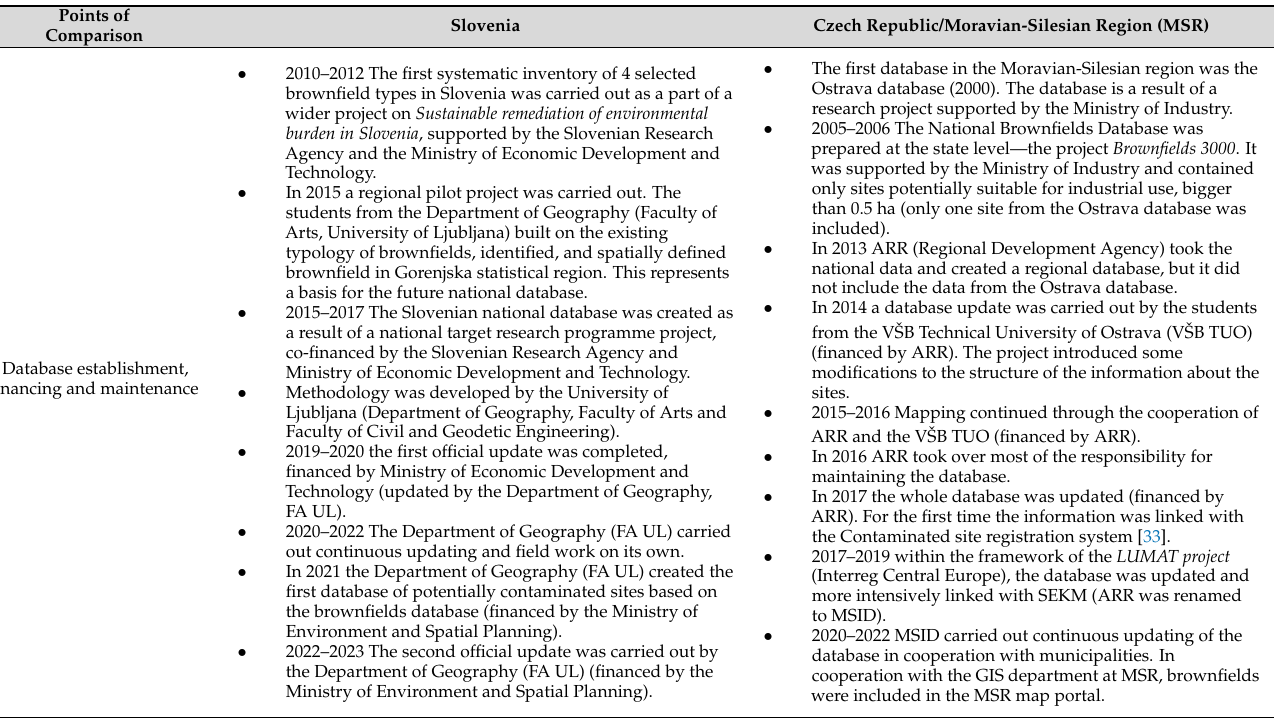
Table 4. Comparison of Slovenian and the Moravian-Silesian brownfield data and database in eight points of